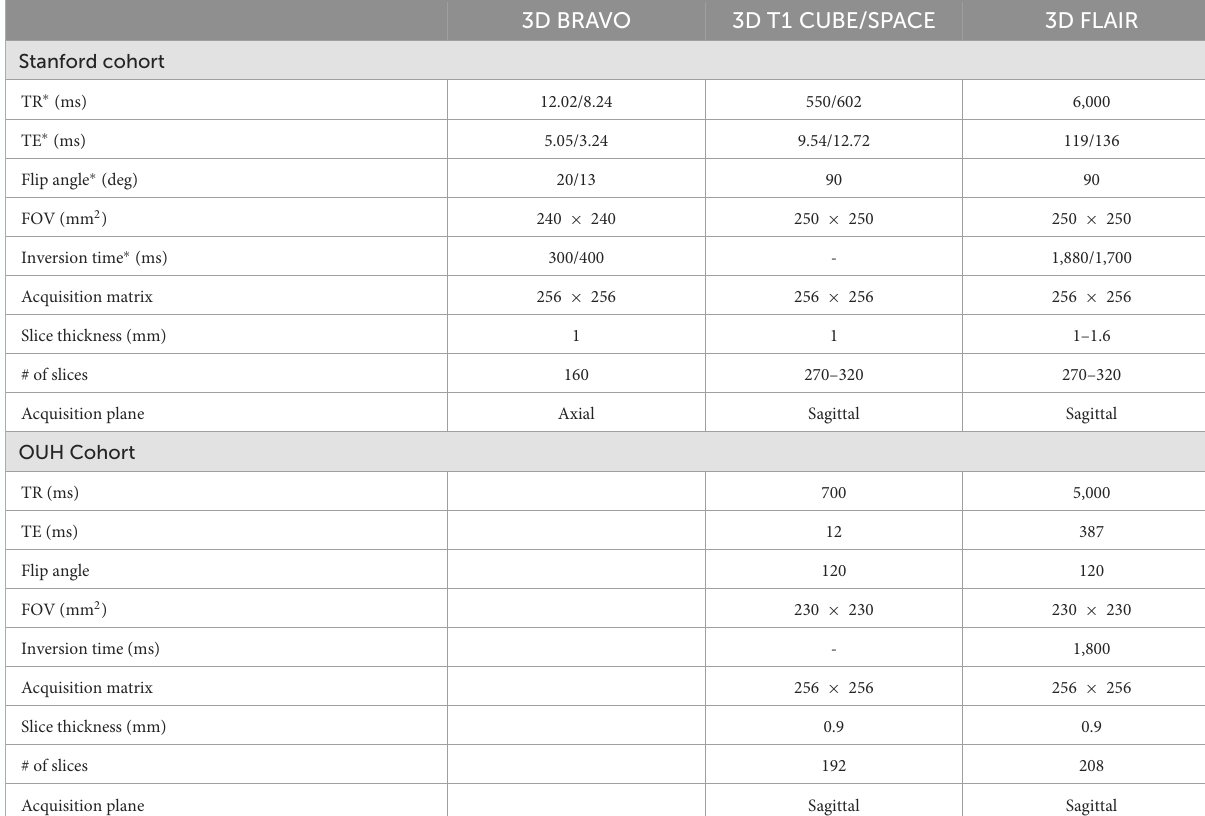
TABLE 1 An overview of the MRI sequence related parameters.